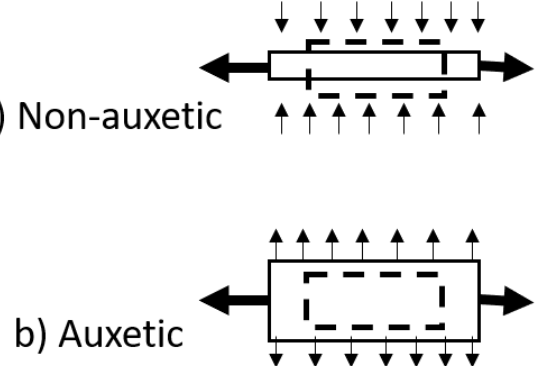
Figure 6. Schematic diagram of positive and negative Poisson’s ratio deformation. ( a ) Non-auxetic behaviour in which an initially undeformed material (dashed outline) undergoes longitudinal extension and lateral contraction (solid line) for a tensile load applied in the longitudinal (x) direction. ( b ) Auxetic behaviour in which an initially undeformed material (dashed outline) undergoes longitudinal and lateral extension (solid line) for a tensile load applied in the longitudinal (x) direction.